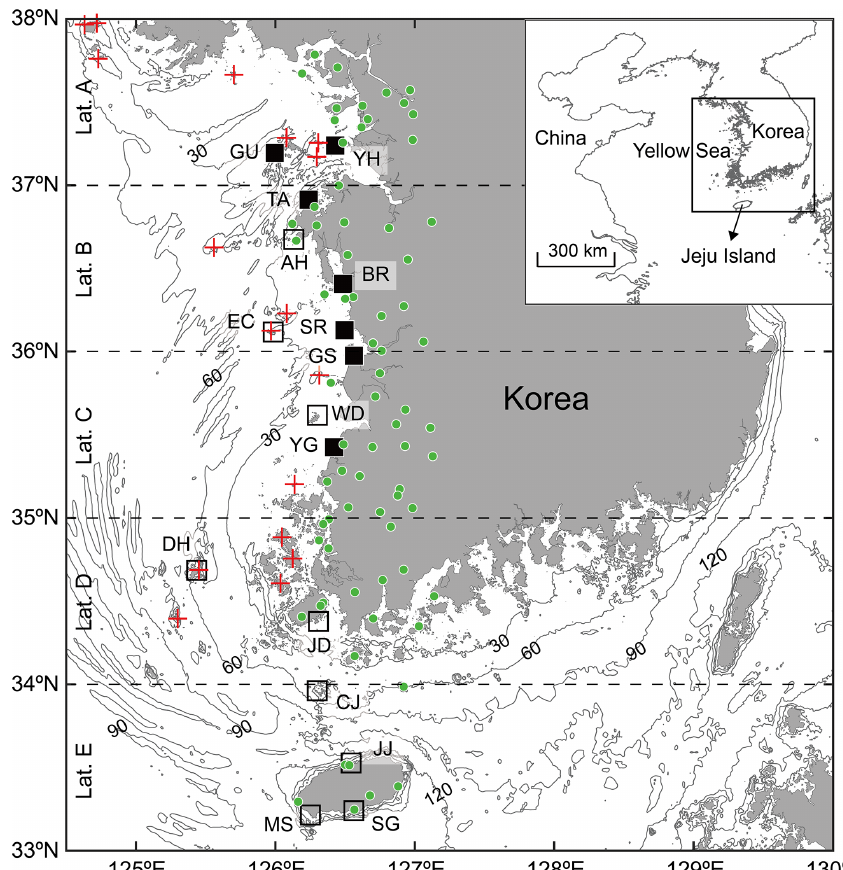
Figure 1. Observation system including 89 automatic weather stations (AWSs) and 16 tide gauges along the coast of the eastern Yellow Sea, with depth contours (m). Red crosses mark the 17 AWSs in the caution zone, which are outward-located beacons of the real-time monitoring system for meteotsunami. Green circles mark the 72 AWSs in the warning zone, intended for timely warnings near the coast. Black squares indicate the 16 tide gauges: Yeongheungdo (YH), Gulupdo (GU), Taean (TA), Anheung (AH), Boryeong (BR), Seochunmaryang (SR), Eochungdo (EC), Gunsan (GS), Wido (WD), Yeonggwang (YG), Daeheuksando (DH), Jindo (JD), Chujado (CJ), Jeju (JJ), Seogwipo (SG), and Moseulpo (MS). The tide gauges were divided into five latitude bands: Lat. A (YH, GU, and TA), Lat. B (AH, BR, SR, and EC), Lat. C (GS, WD, and YG), Lat. D (DH, JD, and CJ), and Lat. E (JJ, SG, and MS). Black empty squares represent the tide gauges located in